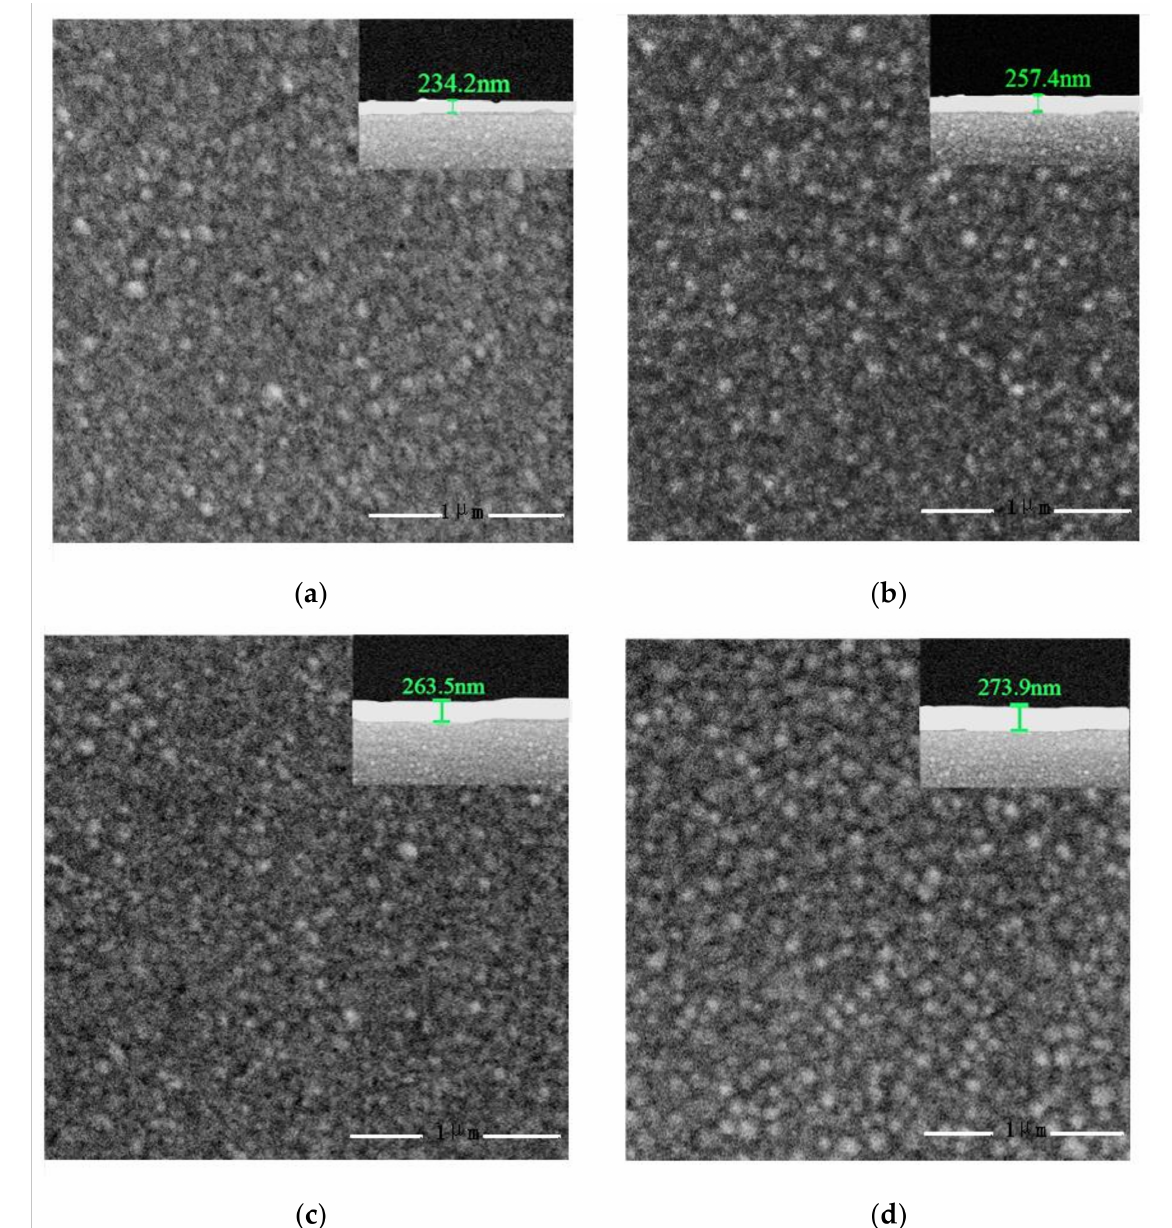
Figure 3. SEM images of surface and cross-section morphologies (inset) of PAA films with different concentrations: ( a ) 0.01 M; ( b ) 0.05 M; ( c ) 0.10 M; ( d ) 0.20